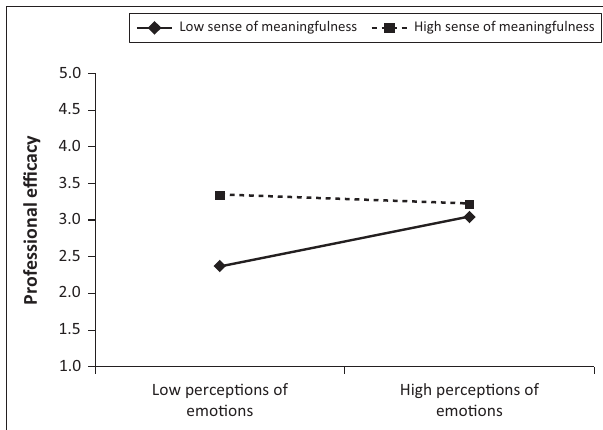
FIGURE 3: Interaction effect (managing others’ emotions x sense of meaningfulness) in predicting professional efficacy.